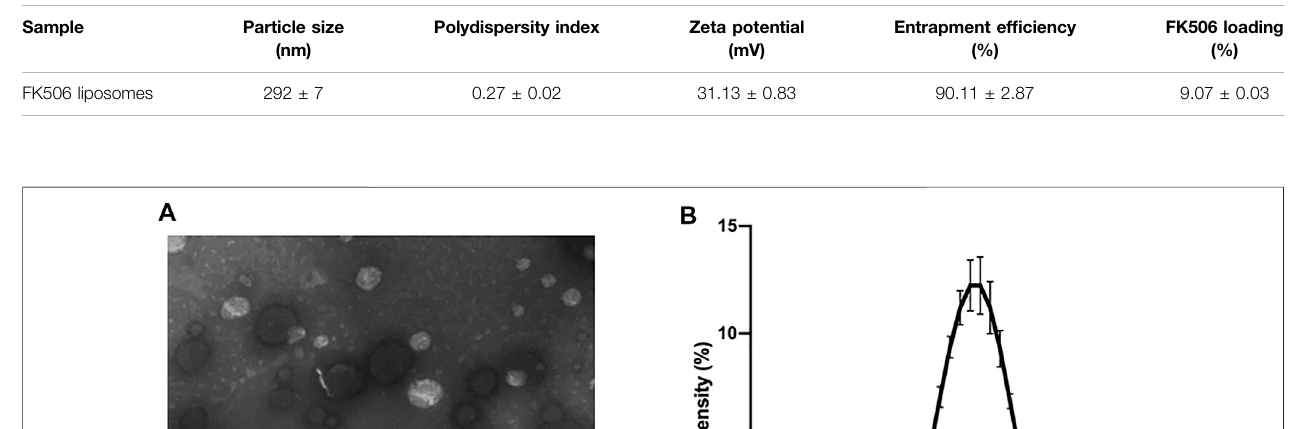
Frontiers in Pharmacology |